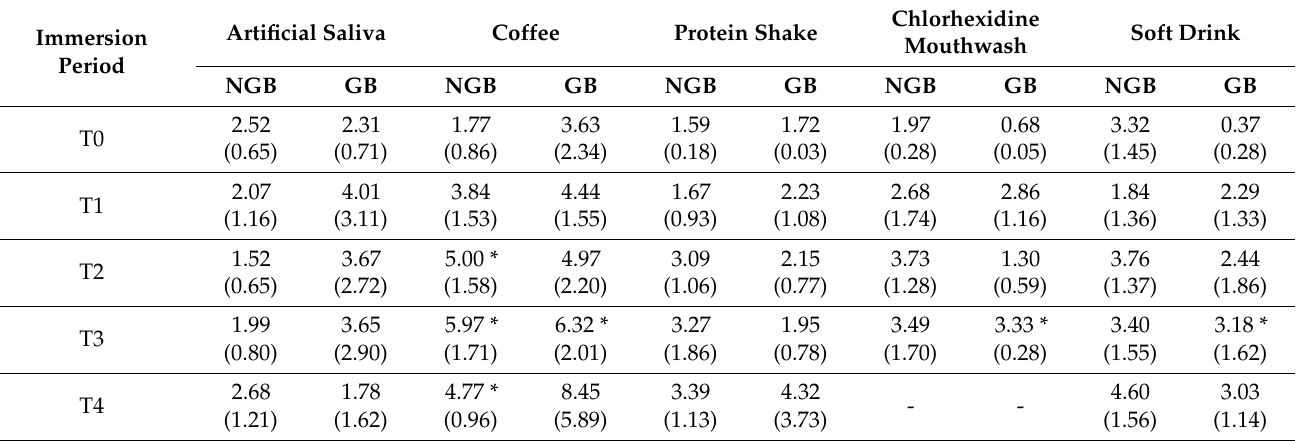
Table 3. ∆ E of multilayer zirconia in different mediums at different times; values are expressed as mean (SD).